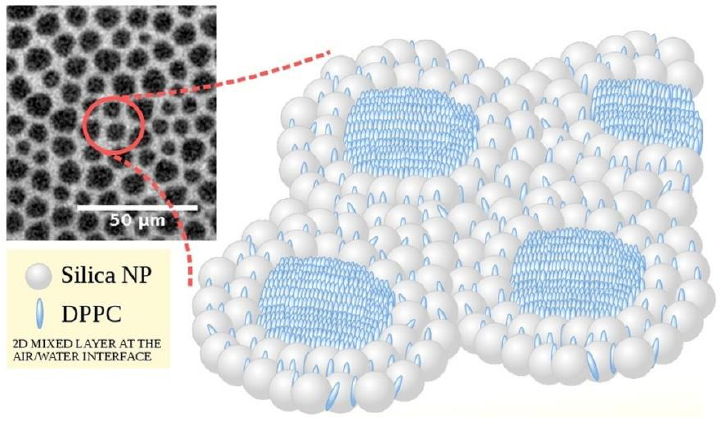
Figure 8. Sketch showing the interfacial organization of interfacial films of DPPC upon the incorpo- ration of hydrophilic silicon dioxide and experimental image of such organization obtained by epifluorescence microscopy. Reprinted from Orsi et al. [178] , with permission under Open access CC BY 4.0 license, https://creativecommons.org/licenses/by/4.0/ (2015). (20 December 2021).